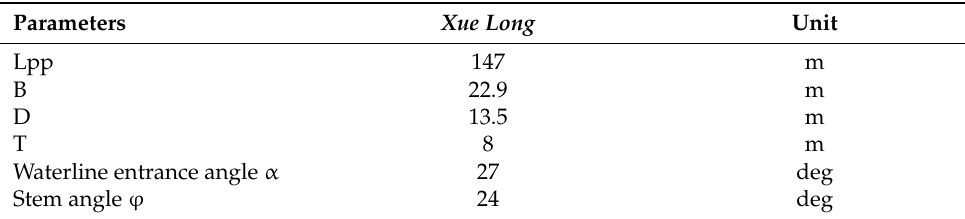
Table 5. Parameters of the icebreaker Xue Long